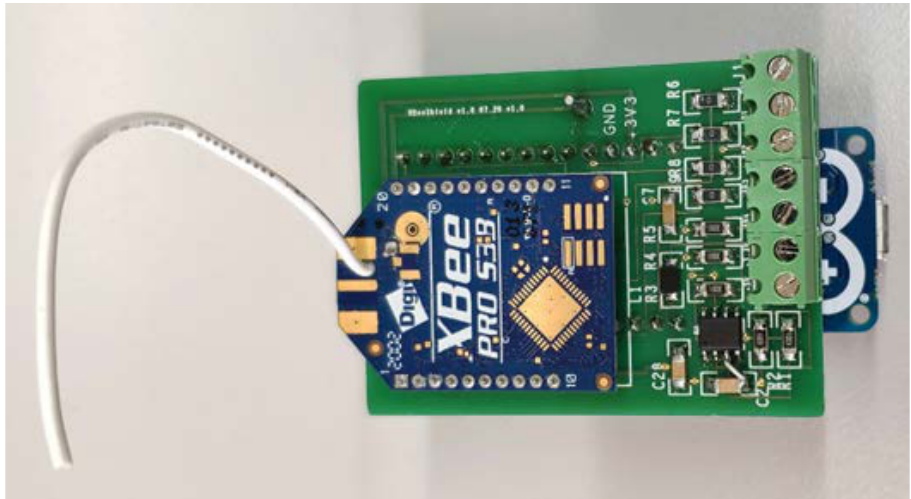
Figure 2. Detail of the Edge Node prototype board.